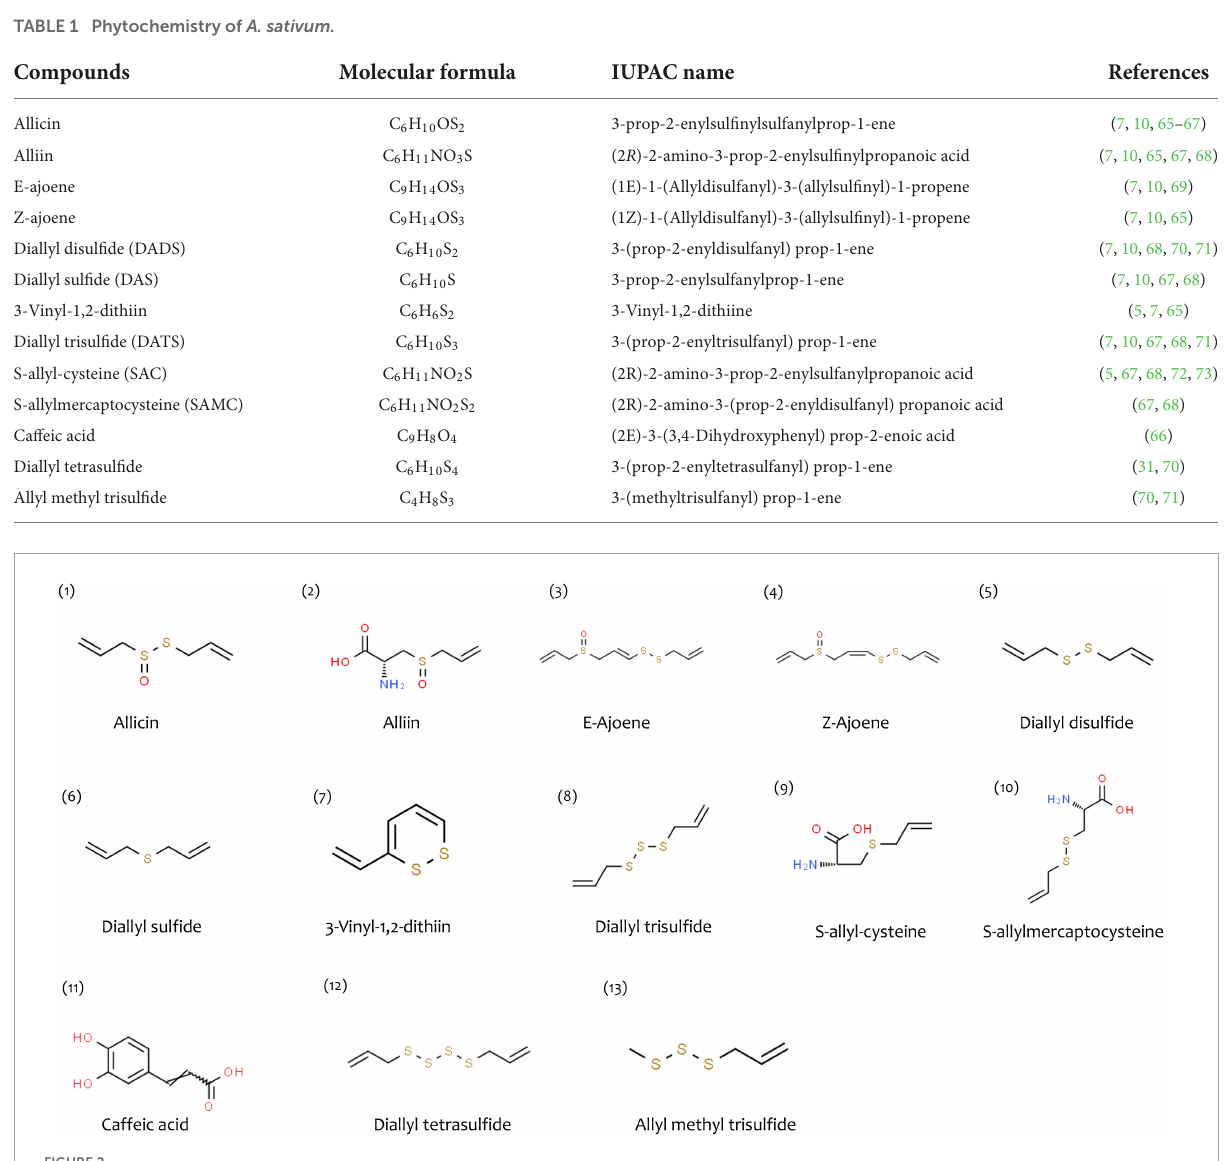
FIGURE2 Structures of some of the phytochemicals reported from A. sativum (obtained from ChemSpider and